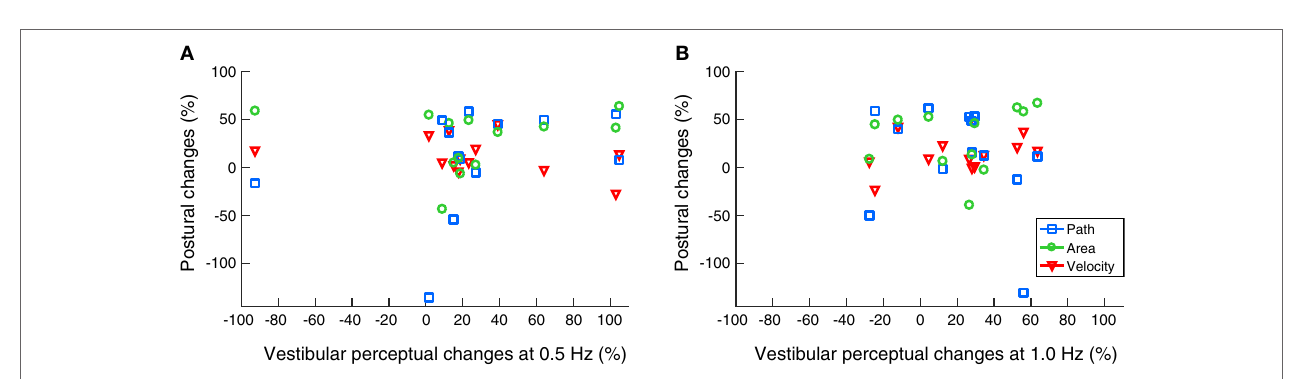
FigUre 3 | Scatter plots on noisy galvanic vestibular stimulation-induced improvements on body balance and vestibular motion perception. No significant correlations were found between the beneficial effects on posture and vestibular recognition thresholds at 0.5 Hz (a) and 1.0 Hz (B) .